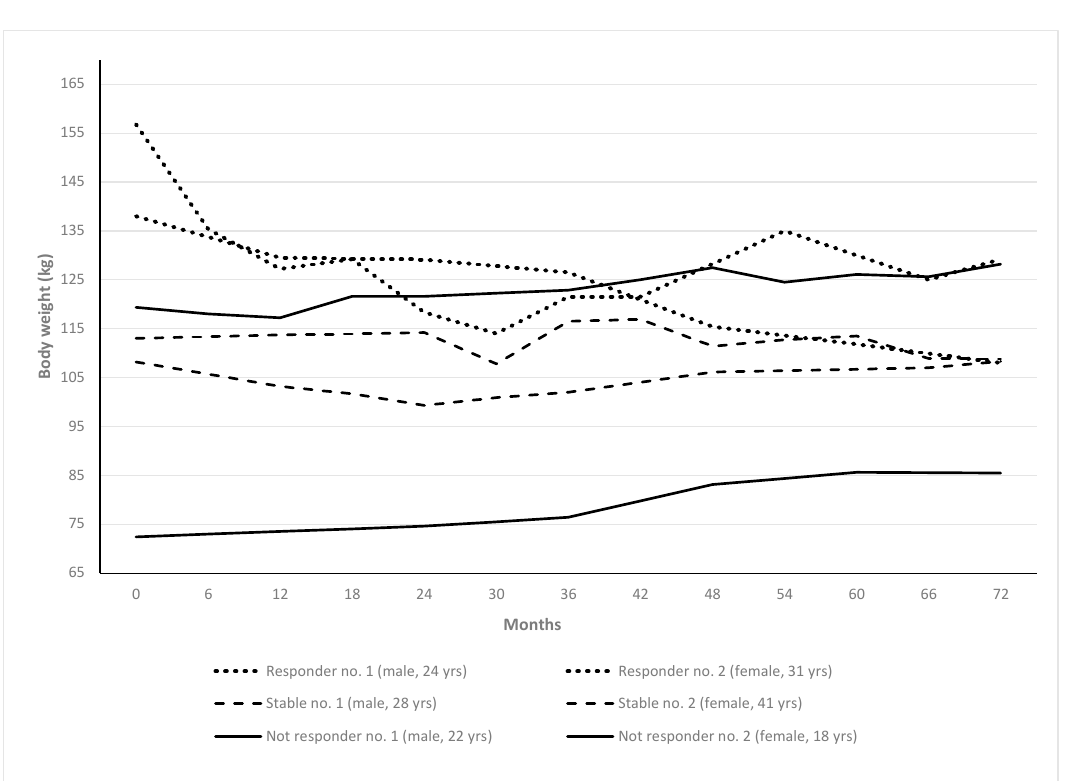
Figure A1. Time-plots of weight at 6-month intervals for 2 patients with weight loss (“responder”), 2 patients with stable weight (“stable”), and 2 patients with weight gain (“not responder”) at 6 years.